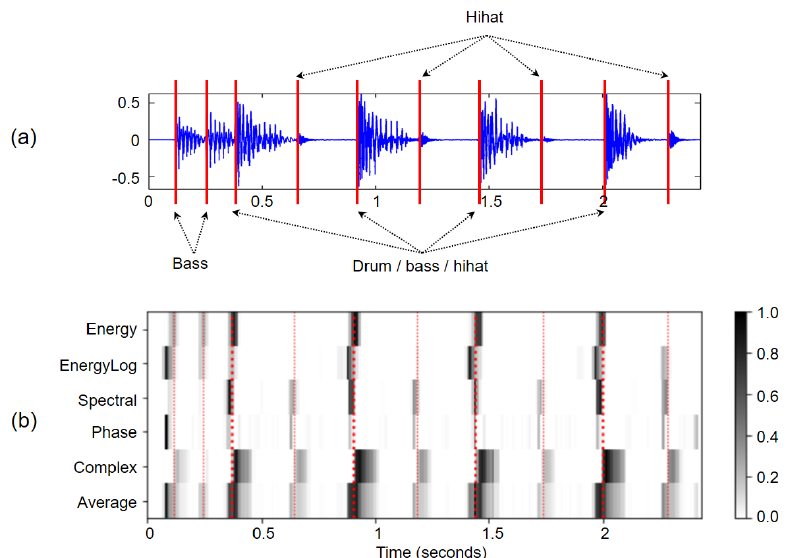
Figure 15. Excerpt of “Another One Bites the Dust” by Queen. ( a ) Waveform representation and annotated note onsets (from [1], Figure 6.1a) ( b ) Comparison of novelty detectors using a matrix- based